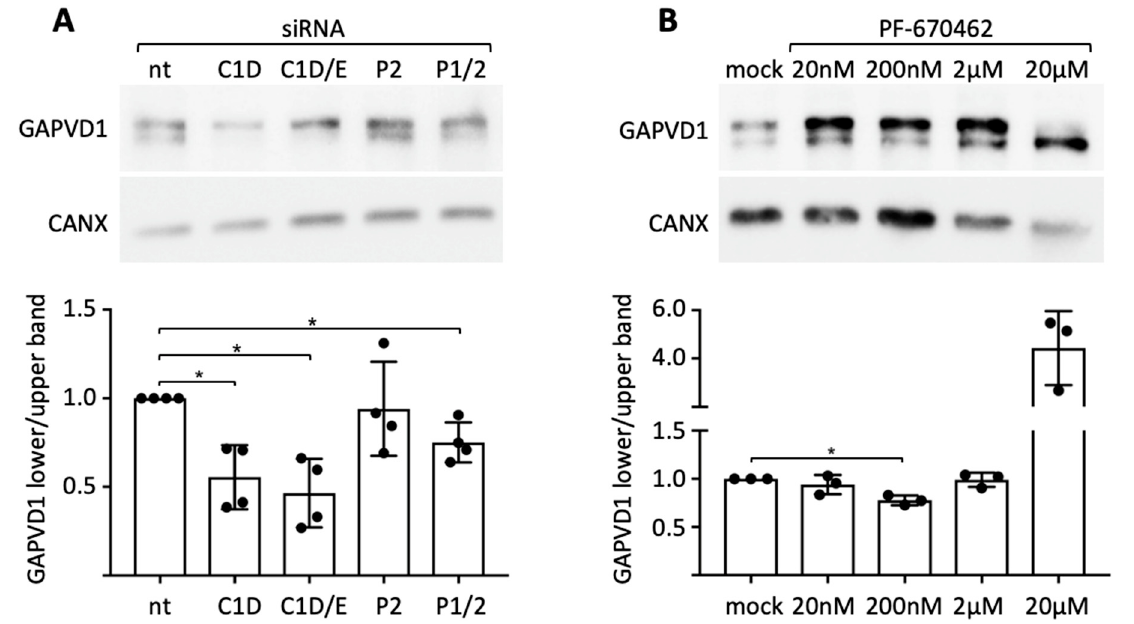
Figure 3. Downregulation of the PER complex components or inhibition of CSNK1D/E kinase activity modulates GAPVD1 phosphorylation levels in HeLa cells ( A ) Western blot analysis of GAPVD1 after treatment with siRNAs against CSNK1D (C1D), CSNK1D/E (C1D/E), PER2 (P2), PER1/2 (P1/2), or non-target siRNA (nt) in HeLa cells; ( B ) Western blot analysis of GAPVD1 after treatment of HeLa cells with increasing concentrations of PF670462 for 18 h. An antibody against Calnexin (CANX) was used as a control for equal loading. Lower panels: Quantification of GAPVD1 protein levels shown as the ratio between the faster (lower) and slower (higher) migrating GAPVD1 protein band normalized to cells treated with nt siRNA or mock-treated cells. Circles show single data points; error bars show standard deviations. * p < 0.05 ( t -test).